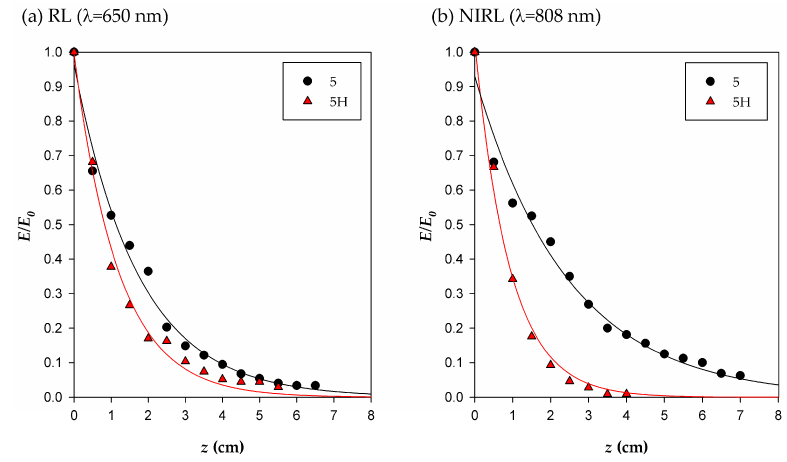
Figure 3. Exponential fit of normalized irradiances from the SGFs as a function of the distance to the coupling point z (cm). The SGFs tested in the experiments were dry ( 5 ) or hydrated ( 5H ) fibers, using ( a ) Red laser (RL) or ( b ) Near-infrared laser (NIRL) as the light sources.